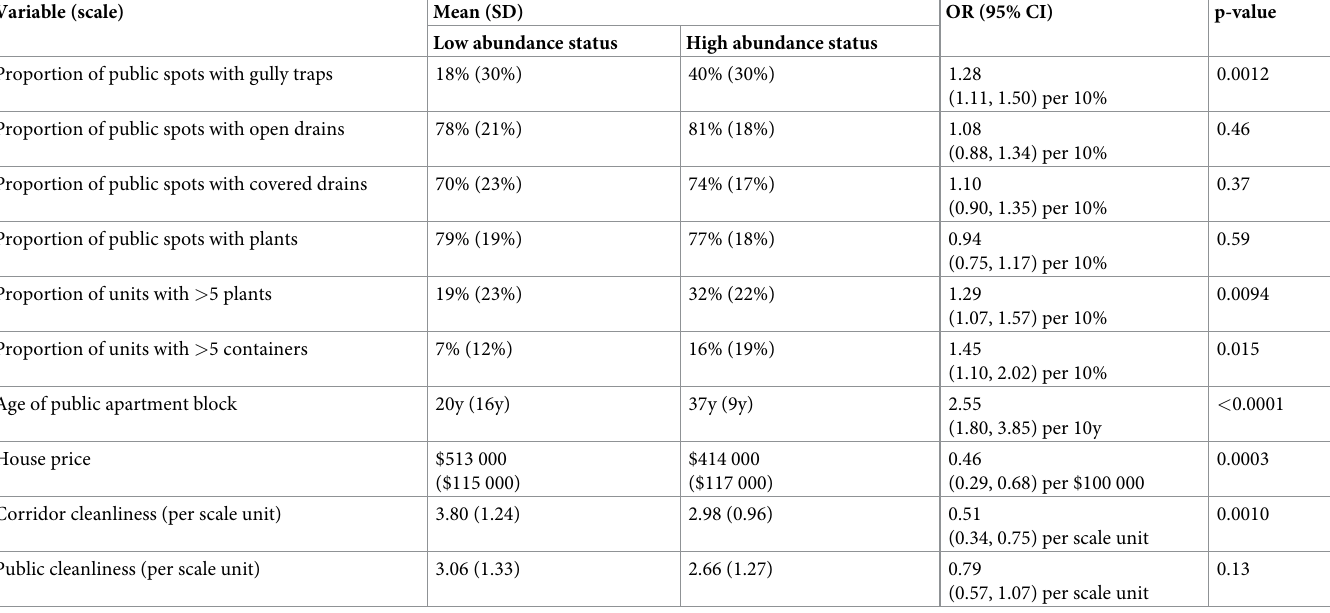
Table 2. Unadjusted logistic